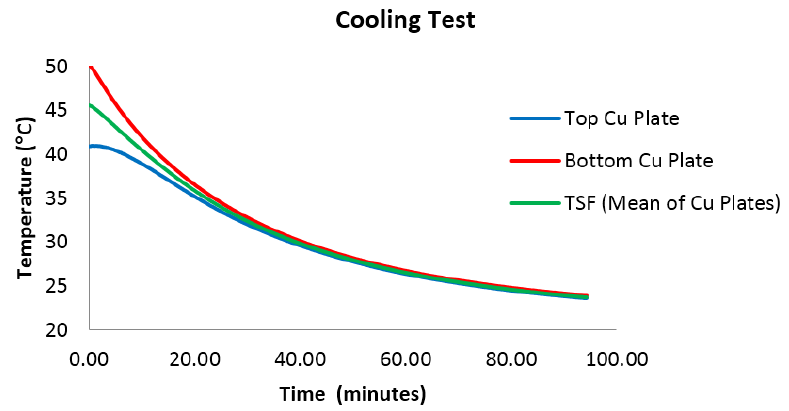
Figure 7. Cooling temperature profiles of Cu plates and TSF.